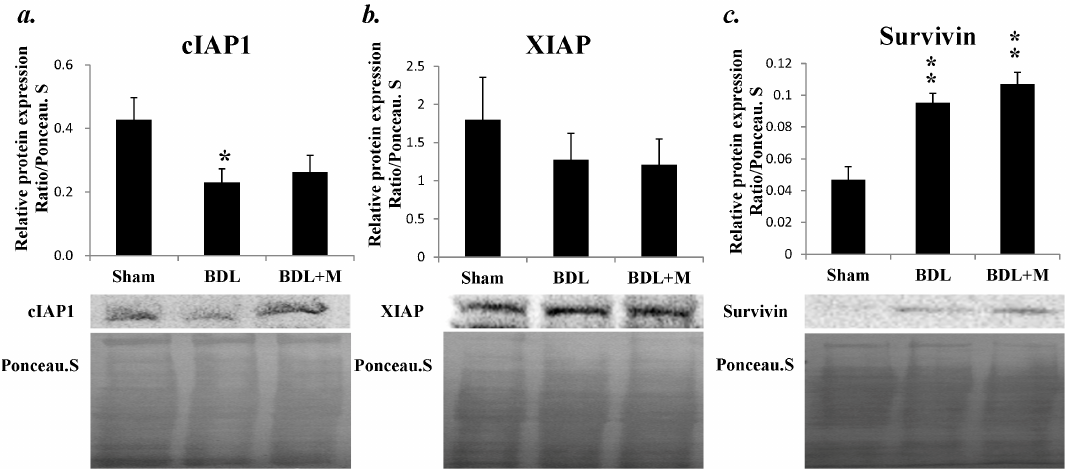
Figure 9. ( a ) Western blot revealed decreased level of cIAP1 in BDL rats; ( b ) both BDL and melatonin treatment did not alter the X-linked inhibitor of apoptosis protein (XIAP) expression; and ( c ) survivin was increased in BDL and BDL + M groups. Significant difference among three groups was analyzed by one-way ANOVA followed by Bonferroni post hoc. All data are shown as mean ± SEM. * p < 0.05 vs. Sham; ** p < 0.01 vs. Sham.